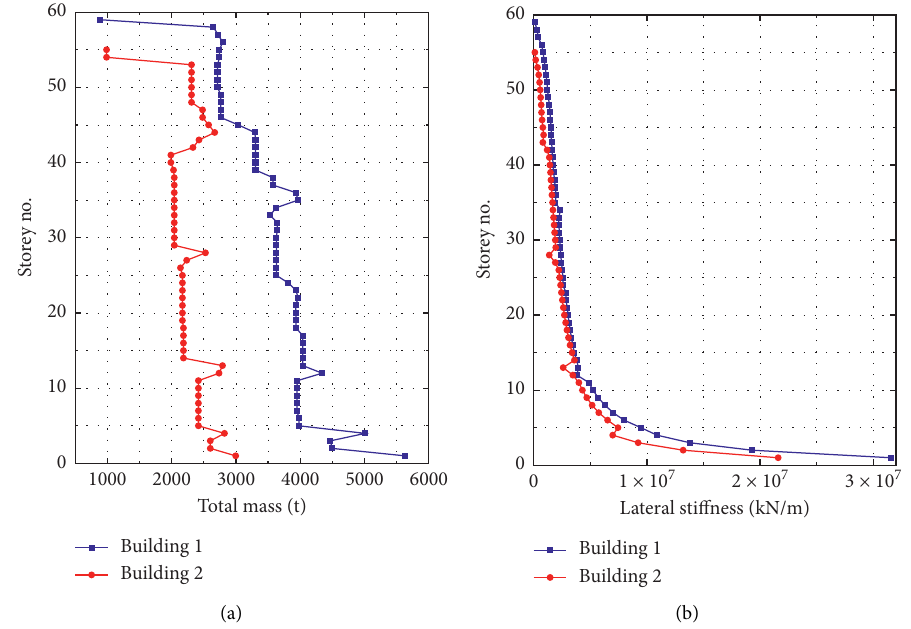
Figure 3: Distribution of (a) lumped masses and (b) lateral stiffness of the two buildings along the x -axis [44]. Table 1: Natural frequencies of individual buildings. Frequency (Hz) f